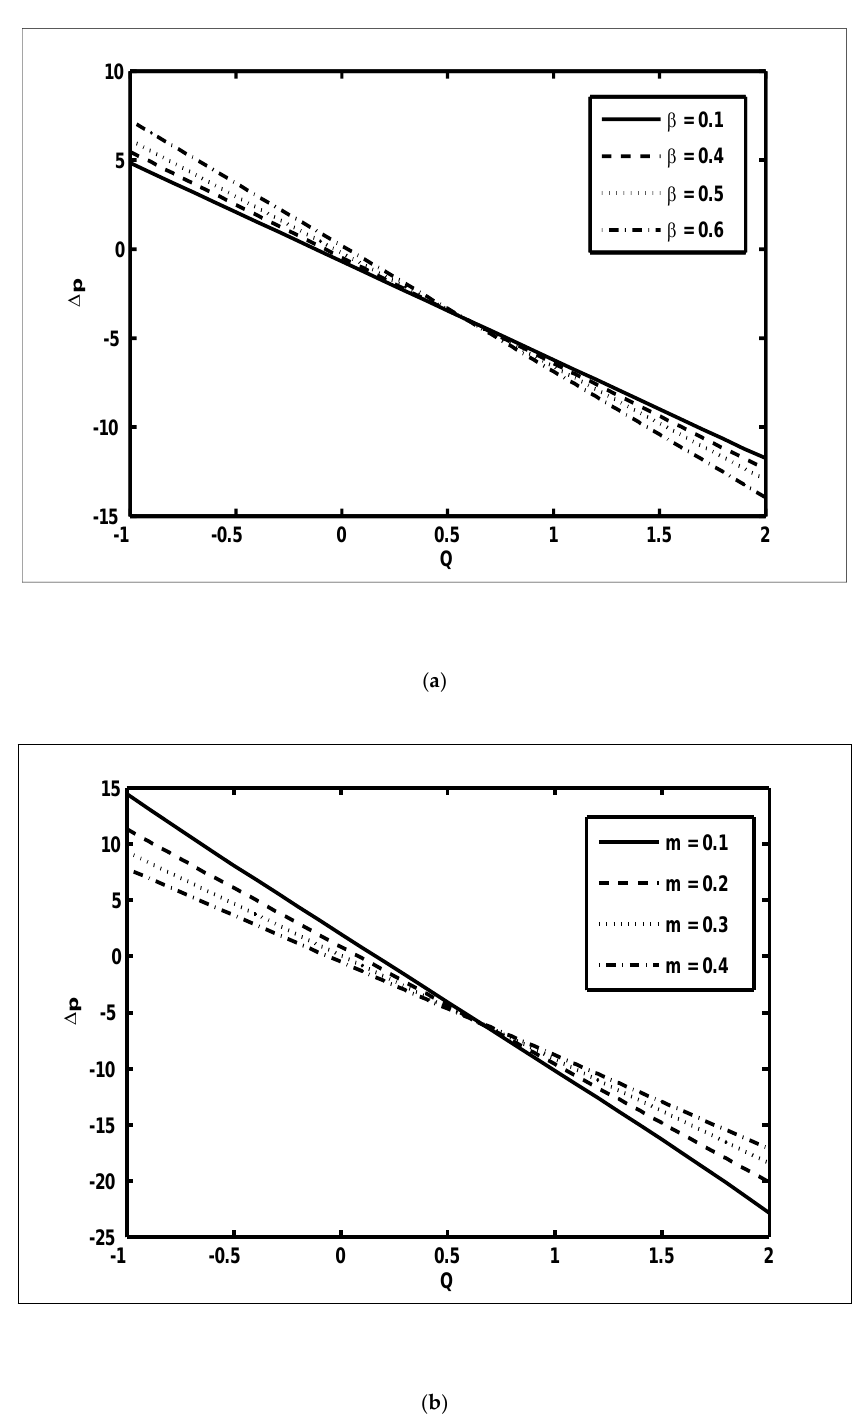
Figure 2. The pressure increase over one wavelength ( ∆ p ) against the volume flow rate ( Q ): ( a ) N CT = 0.3, N TC = 0.7, G rc = 0.4, G rF = 0.1, G rt = 0.5, N t = 0.7, N b = 0.2, M = 4, φ = π Γ = 0.8, m = 0.4; ( b ) N CT = 0.3, N TC = 0.7, G rc = 0.4, G rF = 0.1, G rt = 0.5, N t = 0.7, N b = 0.2, M = 4, φ = π , Γ = 0.8, β = 6